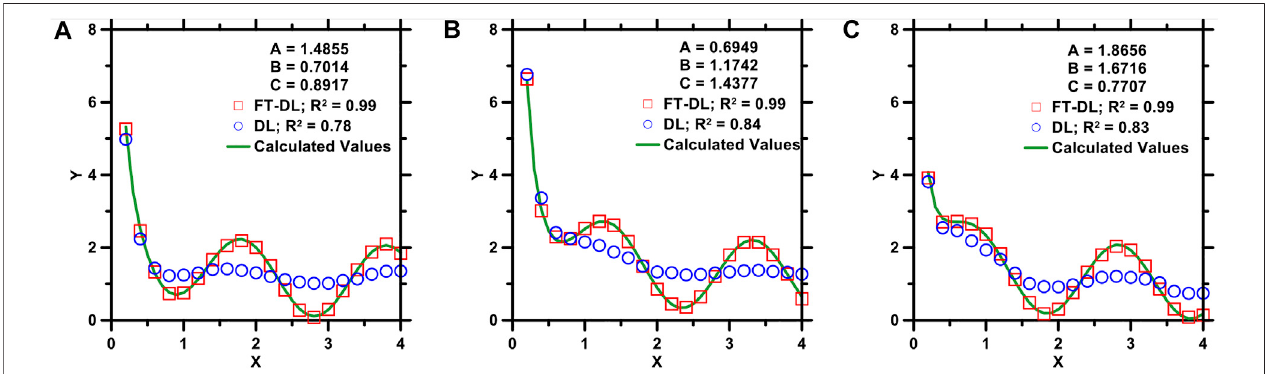
FIGURE 4 | Representative predictions of Y of mathematical functions produced by the DL and FT-DL models plotted against calculated Y values. The input, X , ranges from 0.2 to 2.0. The coef fi cients (A – C) used in the functions, and the models ’ prediction accuracies ( R 2 ), are shown in the